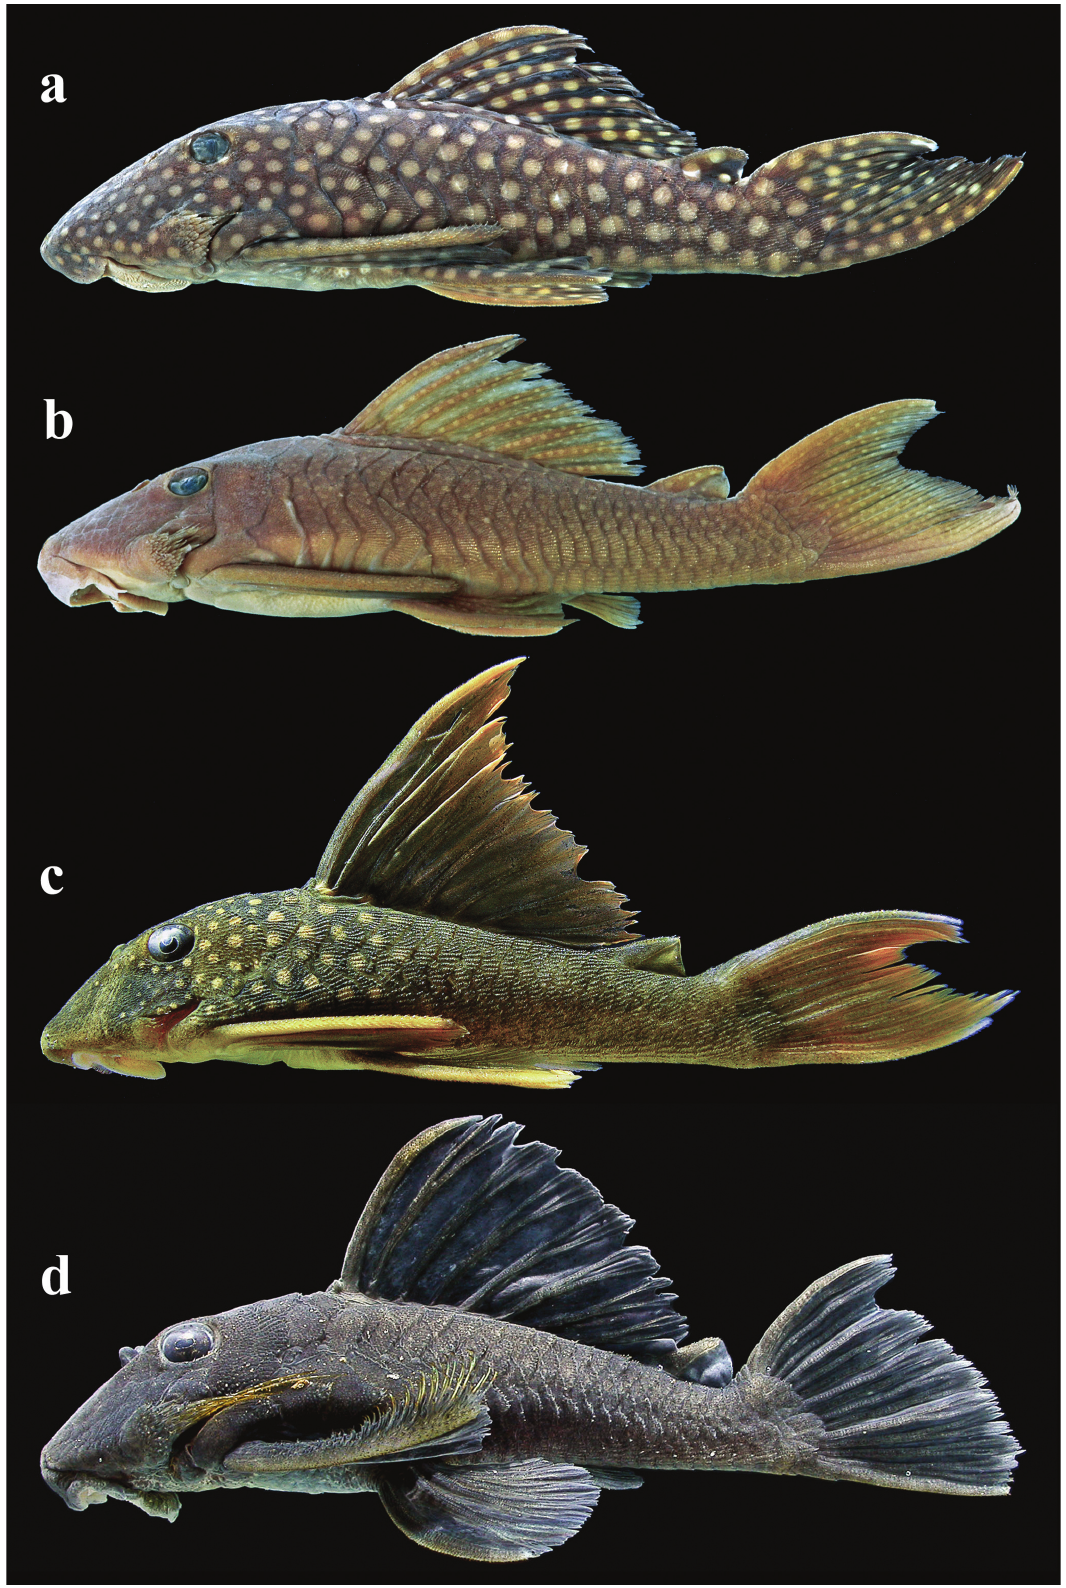
Fig. 7. Lateral view of preserved specimens of ( a ) Baryancistrus niveatus INPA 6051, 121.5 mm SL; ( b ) B . longipinnis INPA 6329, 144.0 mm SL: ( c ) B . demantoides MCNG 54031, 54.1 mm SL; and ( d ) B . beggini AUM 39227, 66.2 mm SL. Photos (a) and (b) by RRO, (c) and (d) by M.